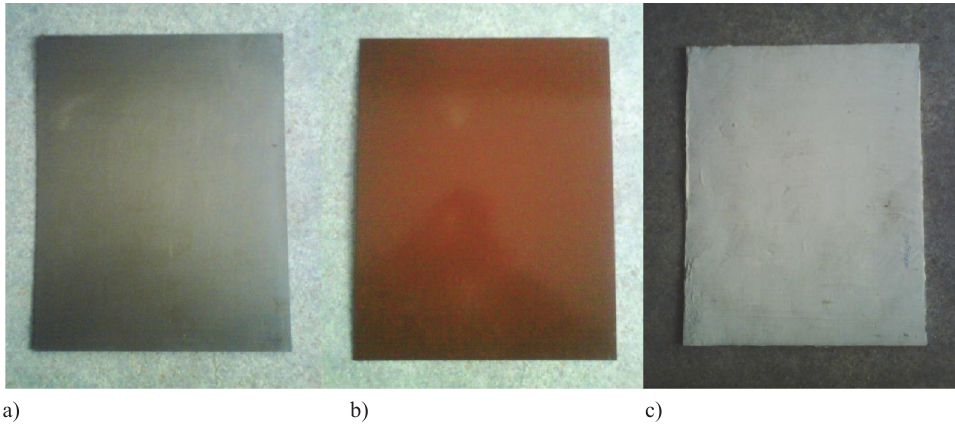
Figure 1. Steel plates for the test preparation phases: a) clean steel plate; b) plate coated with primer; c) plate covered in polymeric intumescent fire